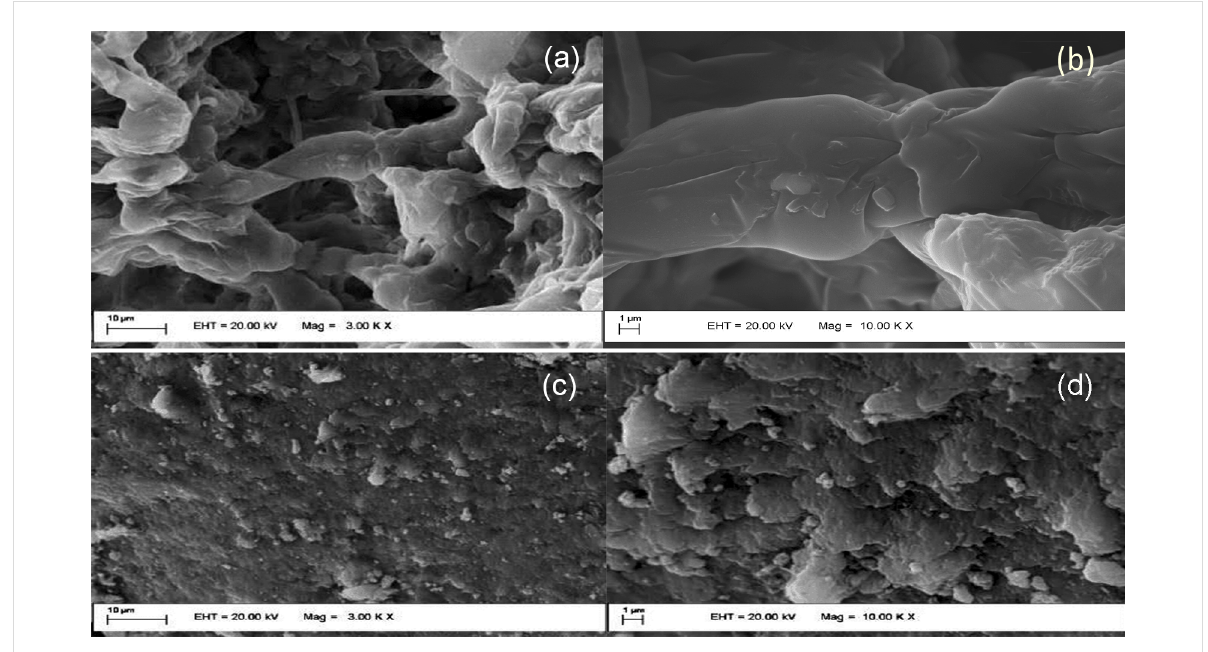
Figure 4: Representative SEM images of (a) NAA (3000× magnification), (b) NAA (10000× magnification), (c) ZnAl-NAA-LDH (3000× magnification), and (d) ZnAl-NAA-LDH (10000× magnification).